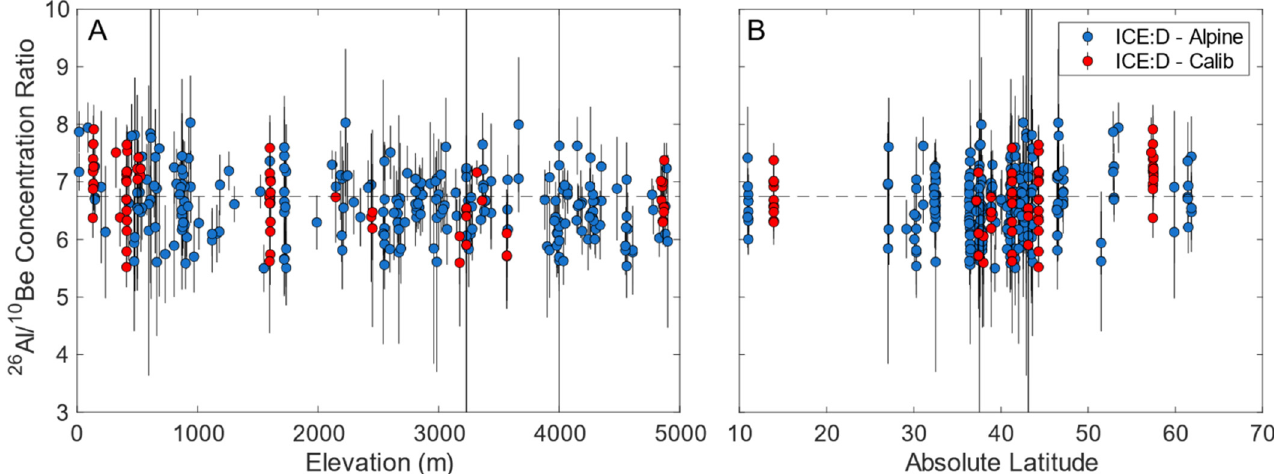
Figure 3. Measured 26 Al/ 10 Be concentration ratios plotted against elevation ( A ) and latitude ( B ). Dashed horizontal line shows the currently accepted production ratio value of 6.75. Samples from the ICE:D—Alpine database are colored blue, samples from ICE:D—Calib are red.